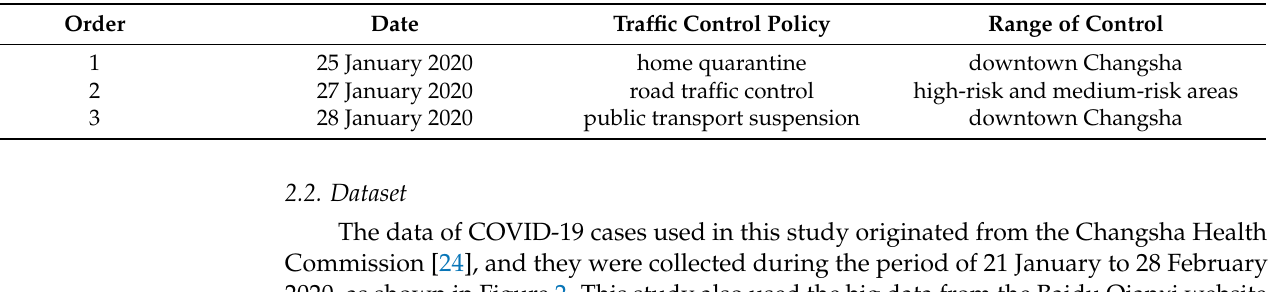
Table 2. Contents of all key measures.